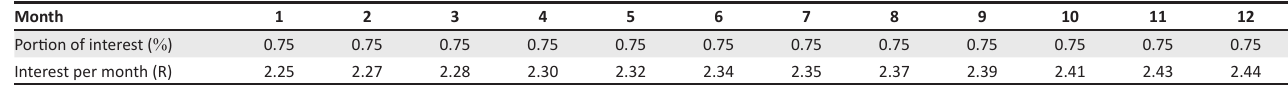
TABLE 3: Different interest amounts per month based on increasing balance.